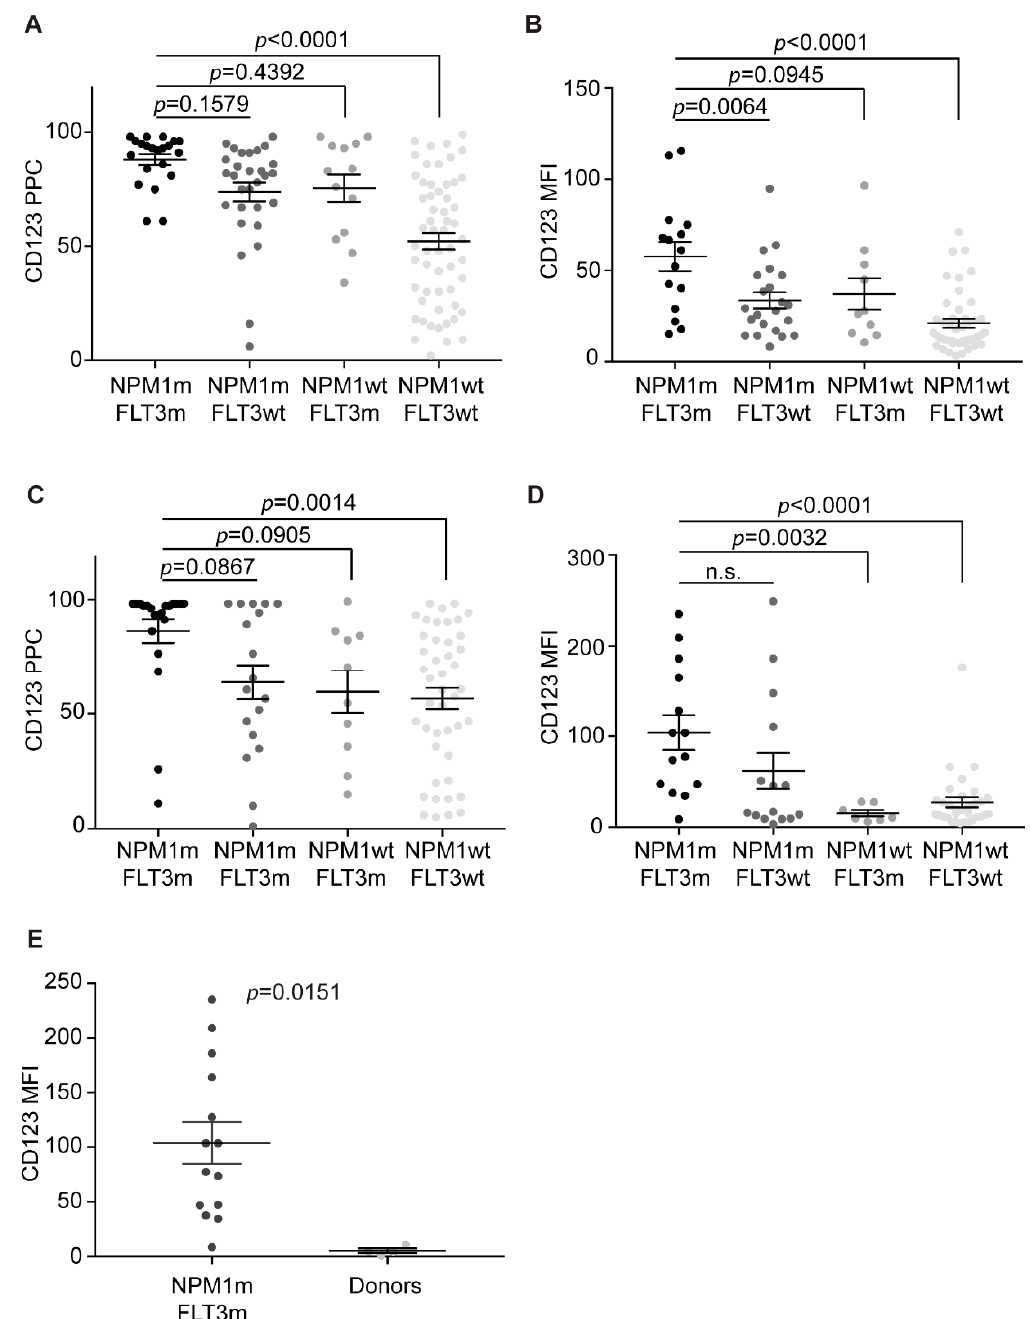
Figure 5. NPM1 mut/ FLT3 -ITD AML LSC express the highest CD123 levels. ( A ) CD123 PPC on bulk AML cells, according to the NPM1 and FLT3 mutational status. Multiple comparisons test. ( B ) CD123 MFI on bulk AML cells, according to the NPM1 and FLT3 mutational status. Multiple comparison test. ( C ) CD123 PPC on CD34 + CD38 − AML cells, according to the NPM1 and FLT3 mutational status. Multiple comparison test. ( D ) CD123 MFI on CD34 + CD38 − AML cells, according to the NPM1 and FLT3 mutational status. Multiple comparison test. ( E ) CD123 MFI on NPM1 mut /FLT3 -ITD CD34 + CD38 − AML cells and CD34 + CD38 − cells from healthy donors. Unpaired t -test. NPM1m, NPM1 mut. FLT3m, FLT3 -ITD. Bars represent mean and standard error.